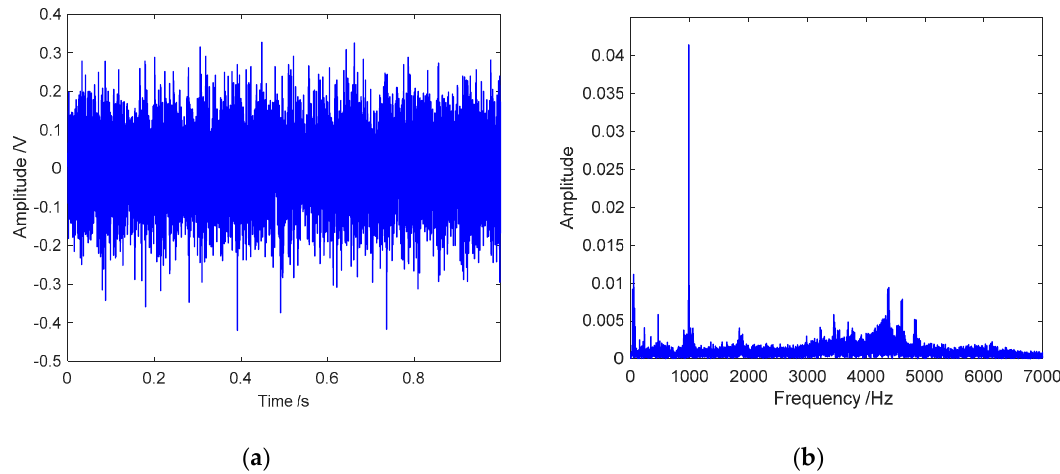
Figure 5. The vibration signal of bearing 1 for further analysis: ( a ) In the waveform only a faint trace of impulse is found; ( b ) the spectrum contains multiple frequency components, with resonance features located at around 1000 Hz, and between 3000 Hz and 5000 Hz.